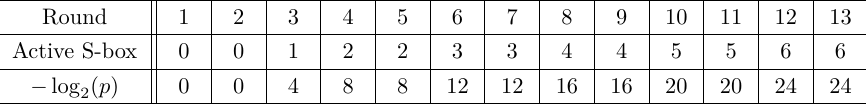
Table 7: Related-key differential properties of PIPO -128.